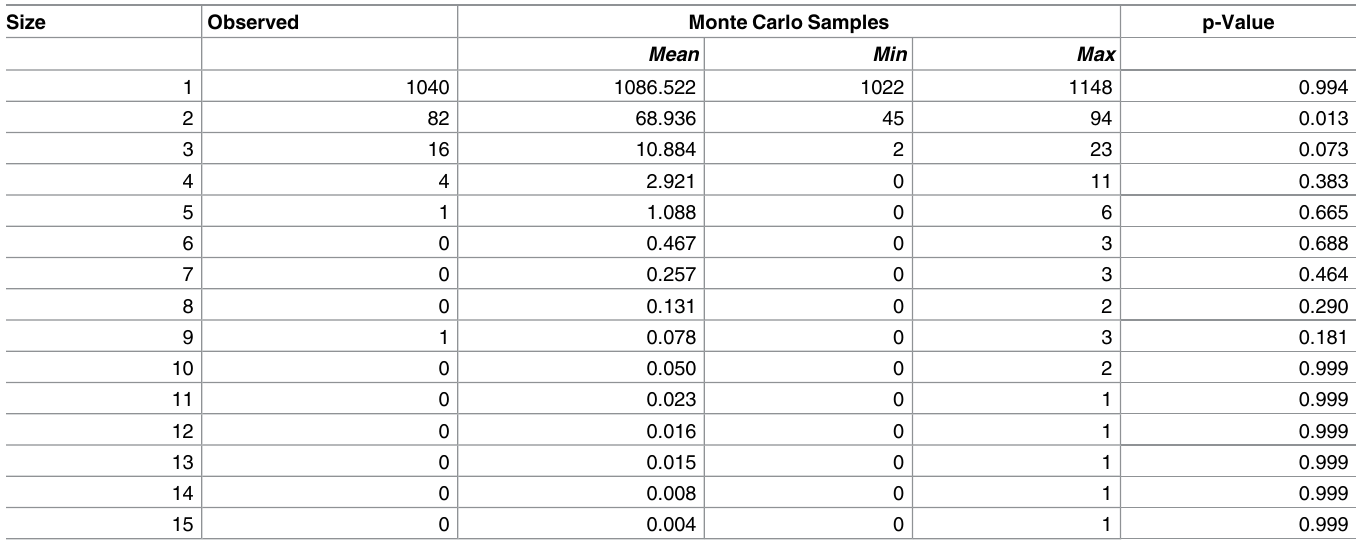
Table 3. Frequency of individual CL clusters by cluster size in the empirical and 999 Monte Carlo samples.